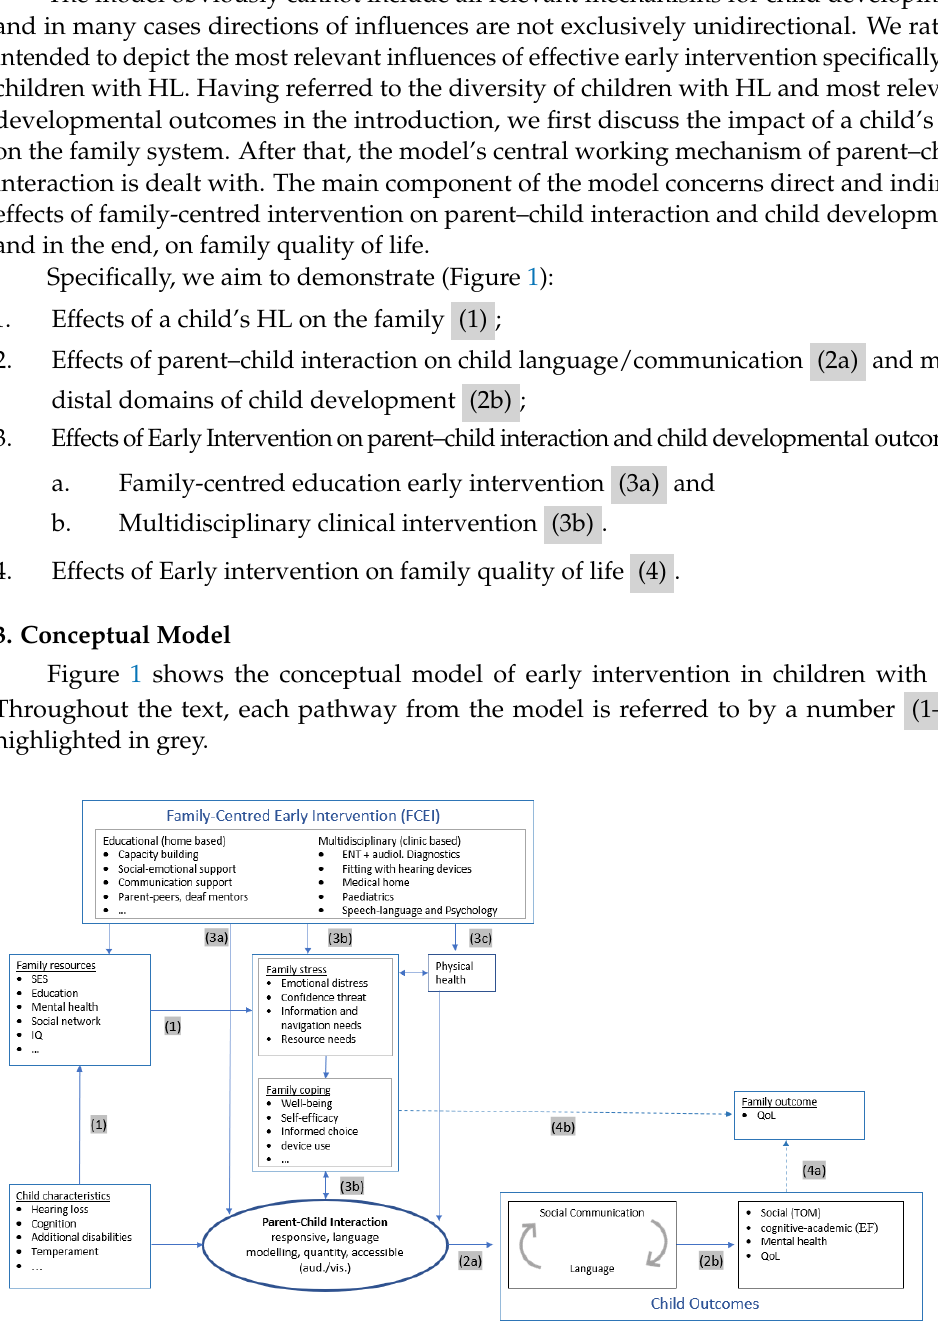
Figure 1. Conceptual model of working mechanisms influencing the relationship between child- hood hearing loss and developmental outcomes. EF: executive function; QoL: quality of life; SES: socioeconomic status; ToM: Theory of